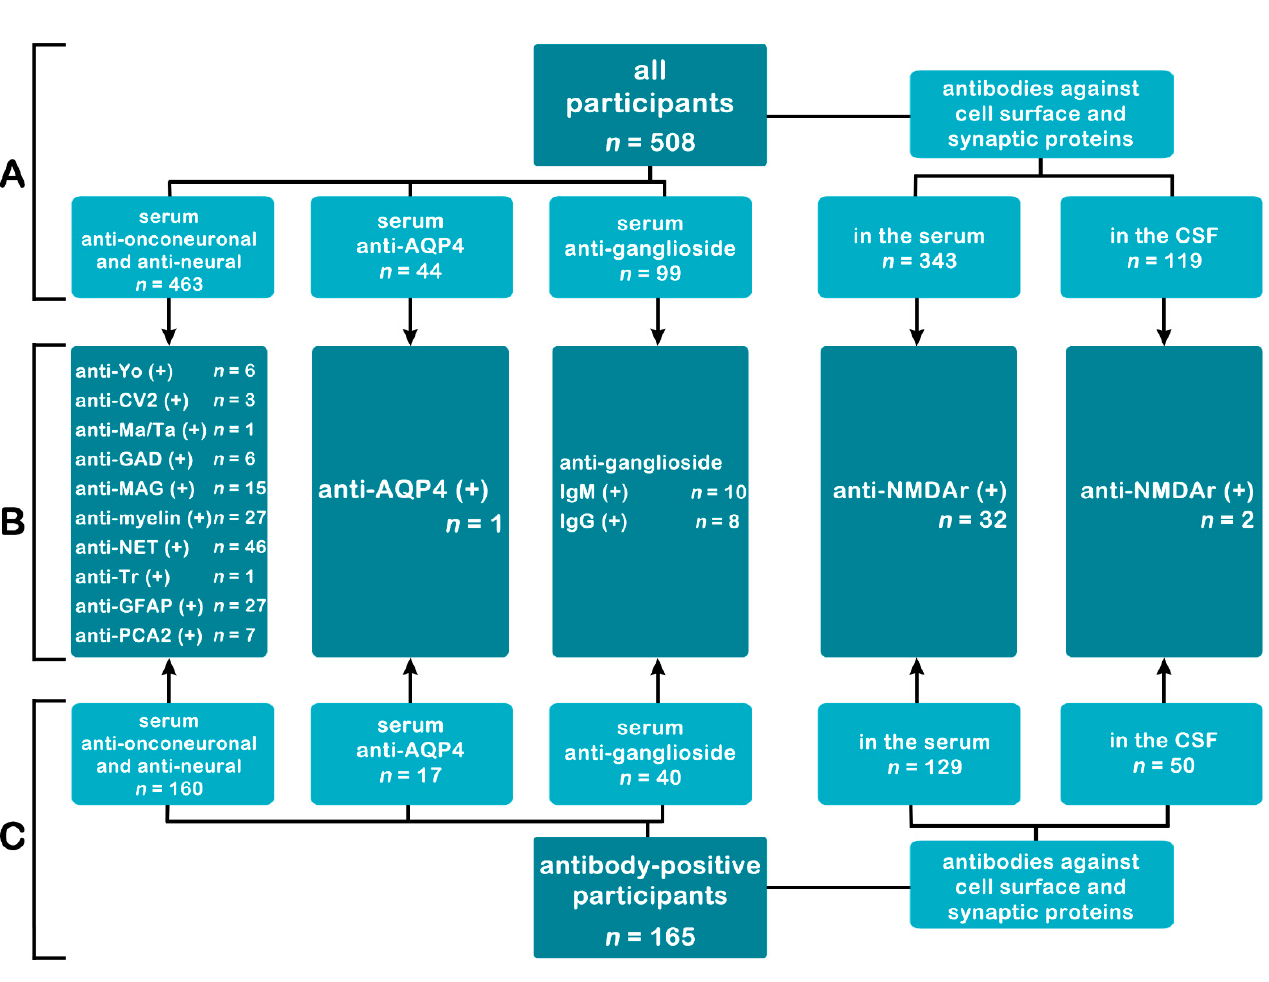
Figure 1. The number of tested patients in subgroups. Part A—the number of patients tested for each group of antibodies in all research participants. Part C—the number of patients tested for each group of antibodies in the antibody-positive subgroup (patients with at least one autoantibody detected). Part B—common to A and C-number of detected antibodies. Abbreviations: anti-Yo—Purkinje cell cytoplasmic antibody type 1; AQP4—aquaporin 4; CSF—cerebrospinal fluid; CV2—collapsin response mediator protein 5; GAD—glutamic acid decarboxylase; GFAP—glial fibrillary